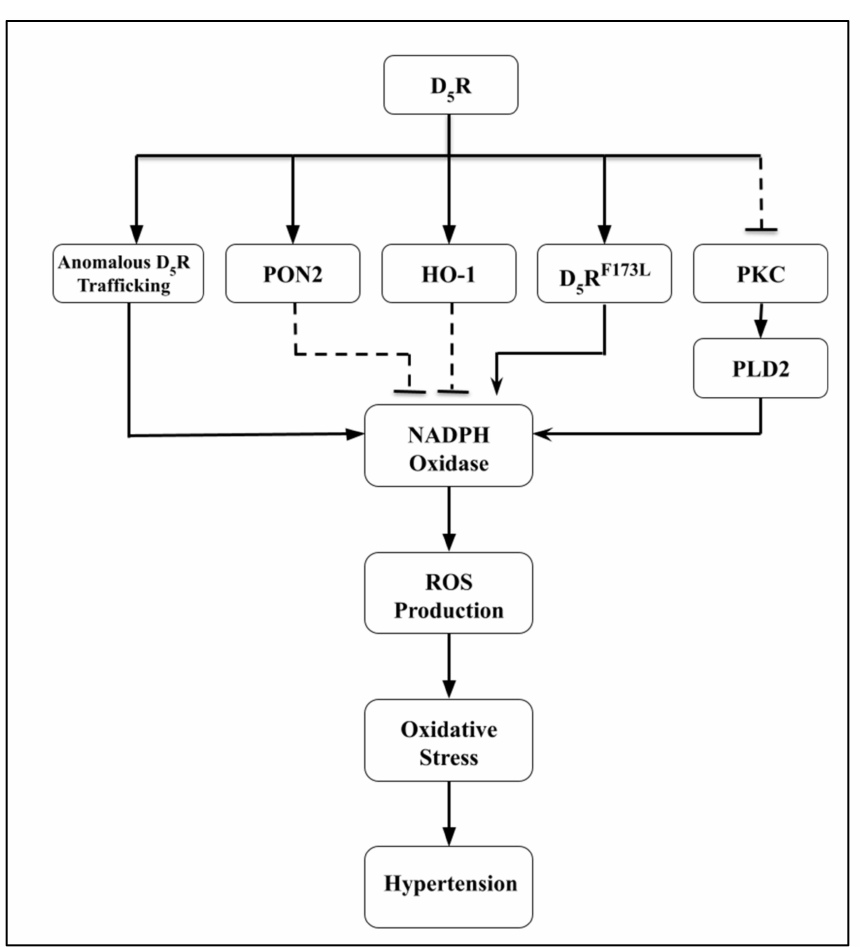
Figure 4. Schematic diagram displaying the role of renal D 5 R and interrelated components on the development of hypertension. The dashed lines illustrate inhibitory effects and solid lines illustrate stimulatory effects. D 5 R, Dopamine D 5 Receptor; PON2, Paraoxonase 2; HO-1, Heme Oxygenase-1; PLD2, Phospholipase D2; PKC, Protein Kinase